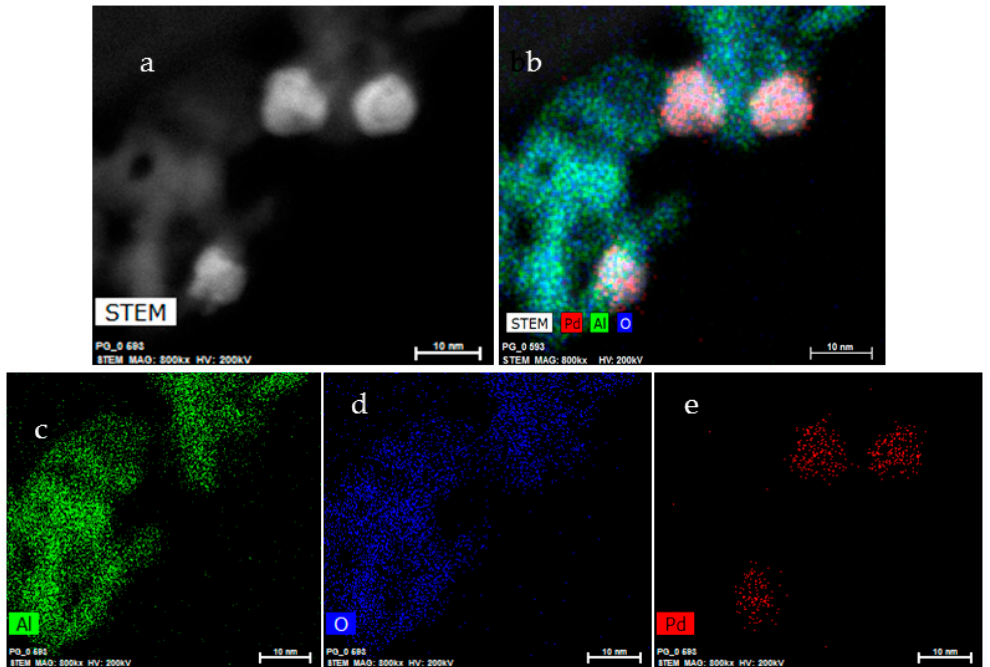
Figure 2. ( a ) STEM image; ( b ) EDS mapping; ( c – e ) contrast STEM images (Al, green; O, blue; Pd red). All STEM images magnification 800 kx, accelerating voltage 200kV; scale, 10 nm.